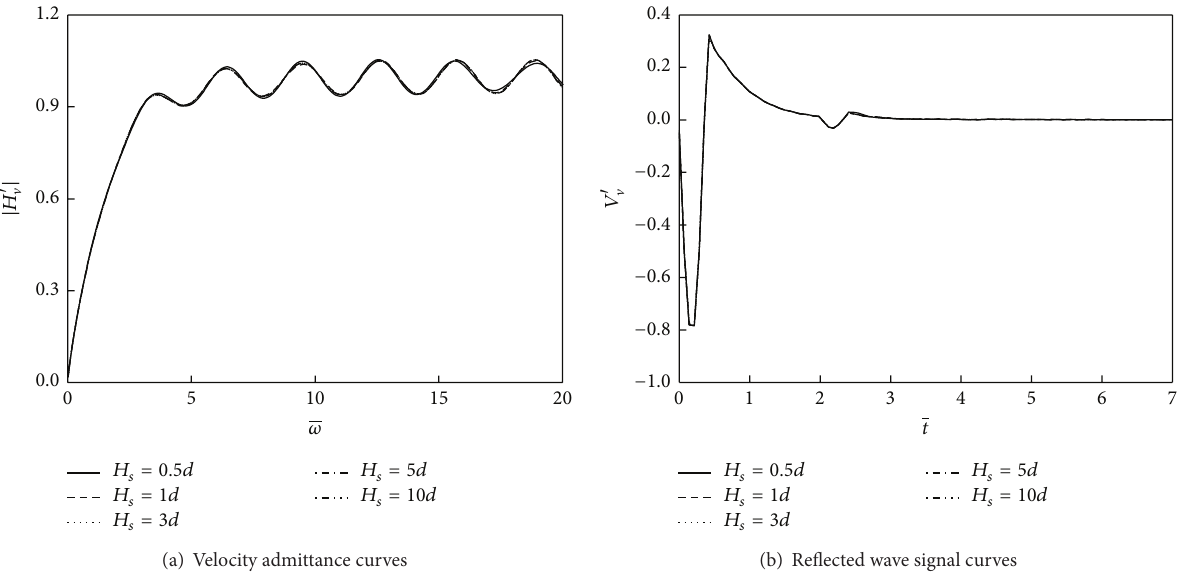
Figure 4: Influence of thickness of pile end soil on the dynamic response at pile head when 𝑟 0 = 0.3 m.